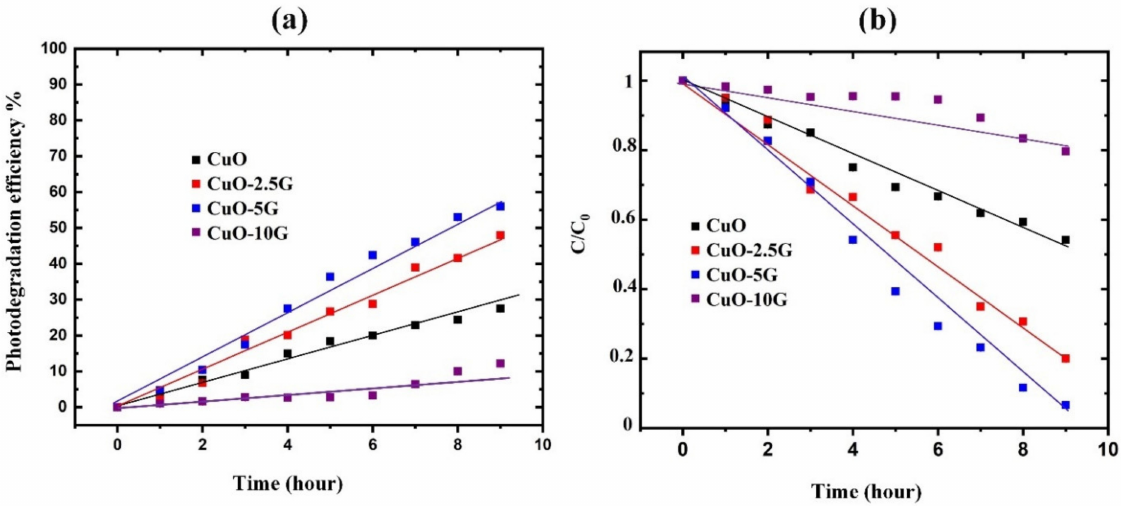
Figure 9. ( a ) Photodegradation efficiency (%) of pristine CuO, CuO-2.5G, CuO-5G and CuO-10G nanocomposites in terms of time of light irradiation and ( b ) the rate of MB dye photodegradation by the